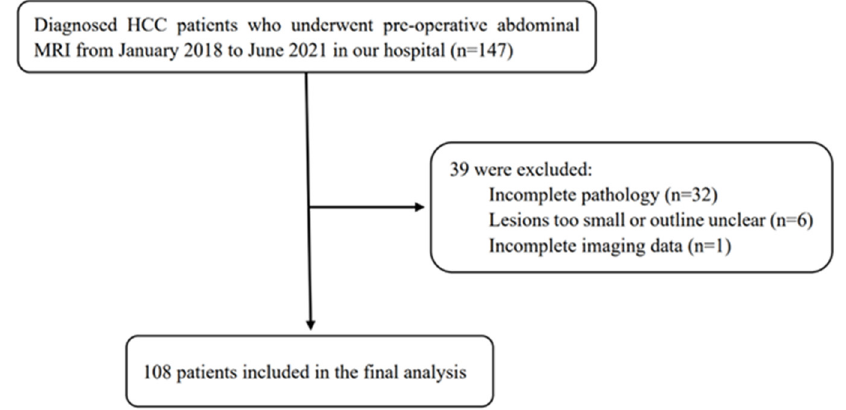
Figure 1. Flow chart of the study population.